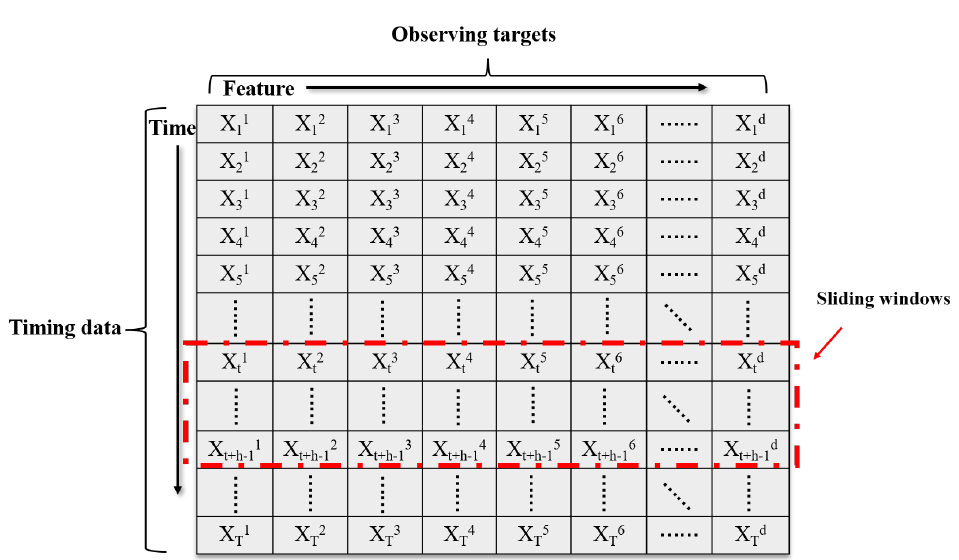
Figure 1. A representation of multivariate time series data captured by the sensor, with each column representing a different targets observed and each row representing test data at a continuous